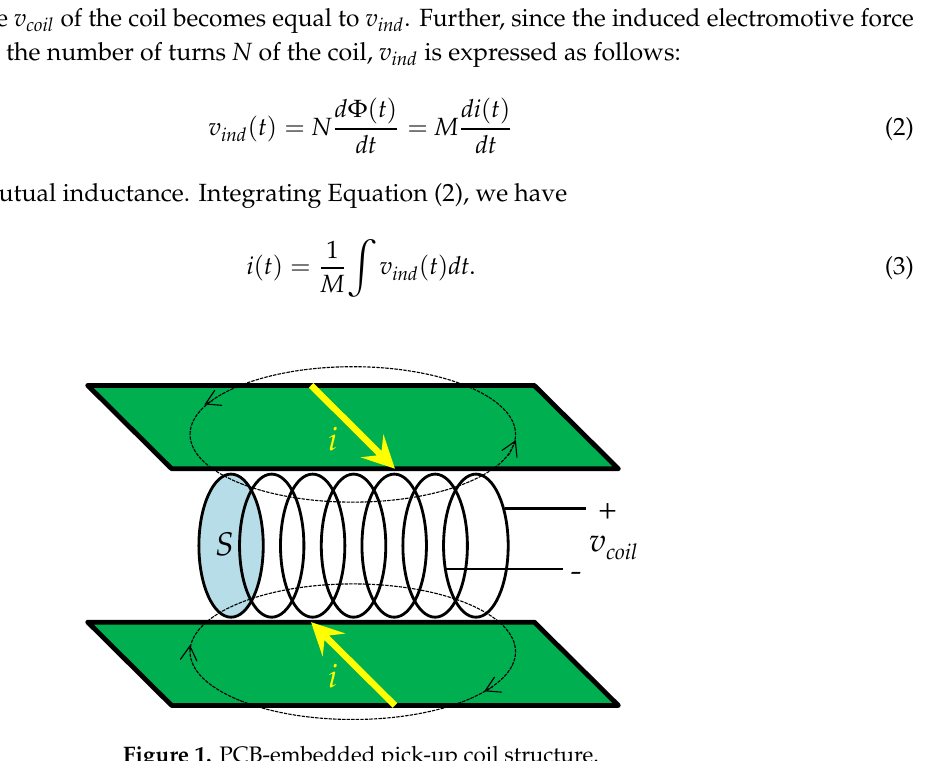
Figure 1. PCB-embedded pick-up coil structure.